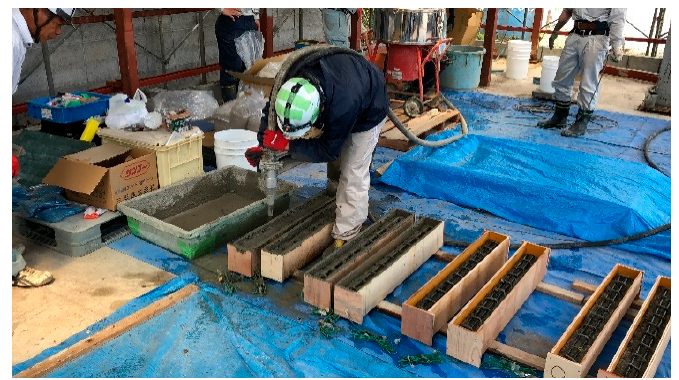
Figure 3. Spraying PCM on the removed section of RC beams. Table 3. Mix proportion of PCM (in 25 kg of PCM).